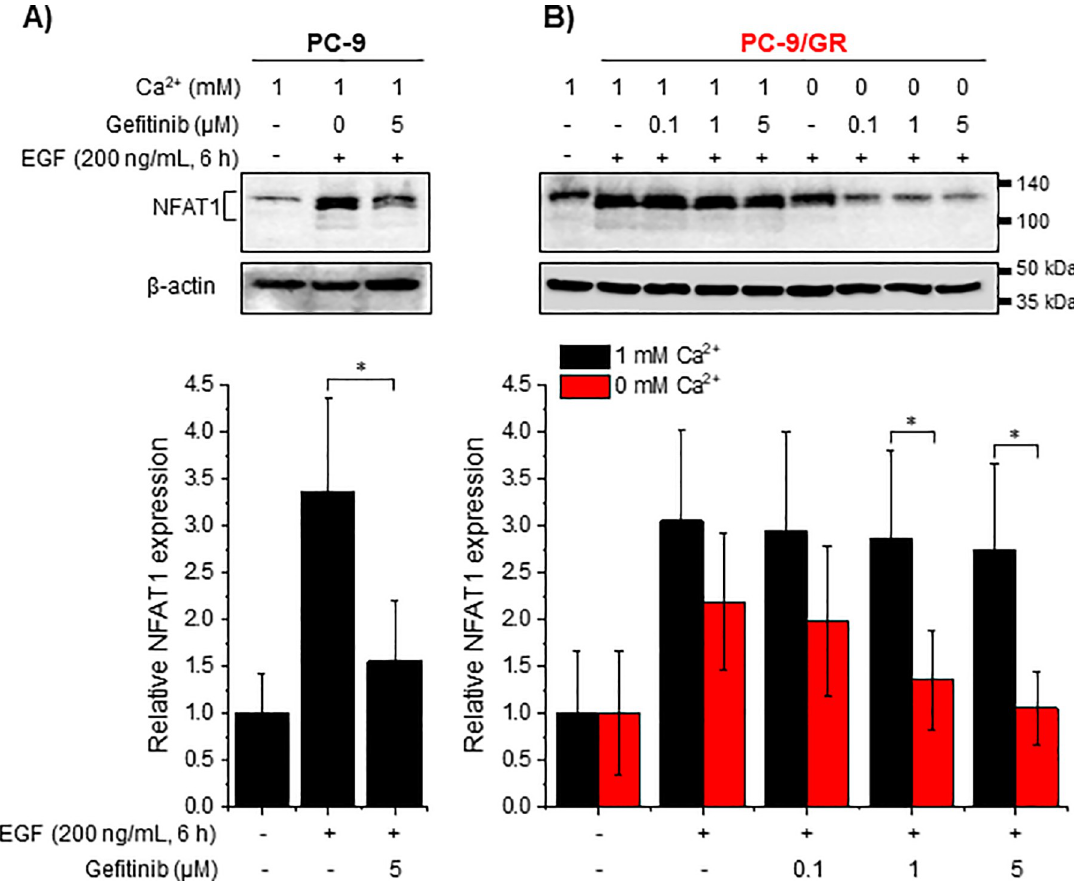
Fig 5. Regulatory effects of low [Ca 2+ ]e on EGF-mediated NFAT1 induction. PC-9 and PC-9/GR cells were incubated under the indicated conditions for 6 h, and whole cell lysates were used for determining NFAT1 induction. (A) Inhibition of EGF-mediated NFAT1 induction in PC-9 cells (B) Sustained EGF-mediated NFAT induction and attenuation of EGF-mediated sustained NFAT1 induction in PC-9/GR cells. The column shows the fold-increase of NFAT1 expression compared with control (cells treated without EGF and gefitinib in the presence of [Ca 2+ ]e. Data are mean ± S.D. � P < 0.05 compared with control or between indicated groups.